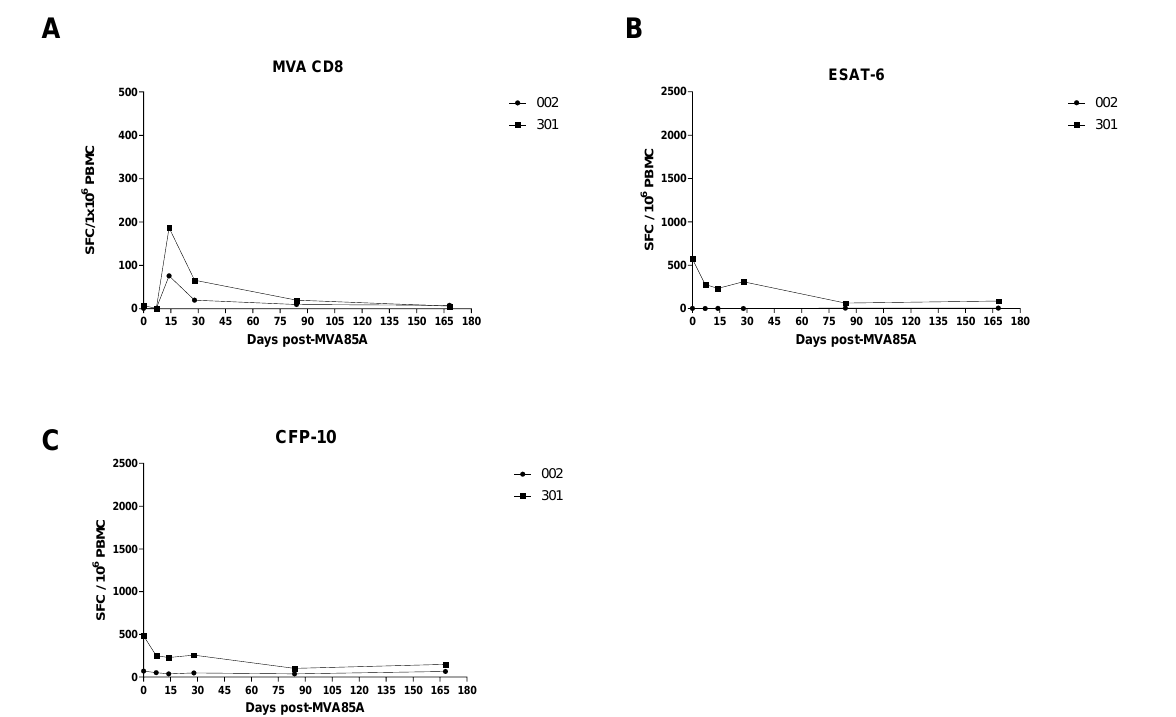
Figure 3. Frequency of antigen-specific IFN-γ ELIspot responses to ( A ) MVA CD8, ( B ) ESAT-6, and ( C ) CFP-10 in two volunteers. x axis: timepoints in days; y axis: spots per 1 × 10 6 peripheral blood mononuclear cells.